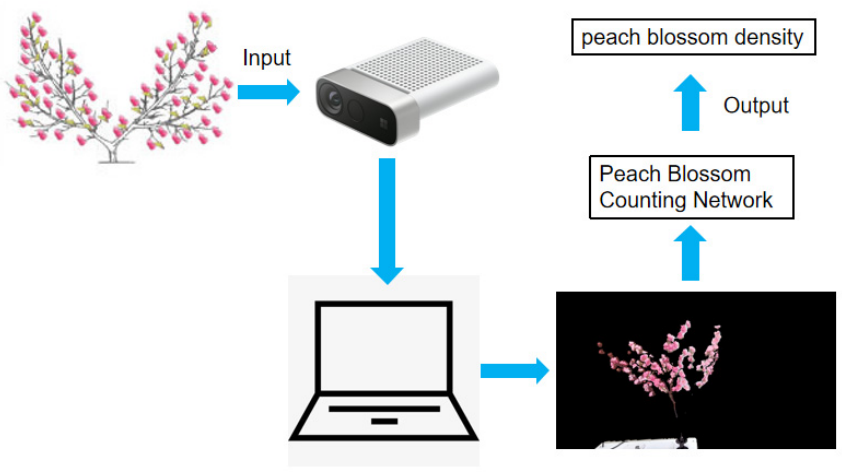
Figure 1. Overall workflow of the proposed method.